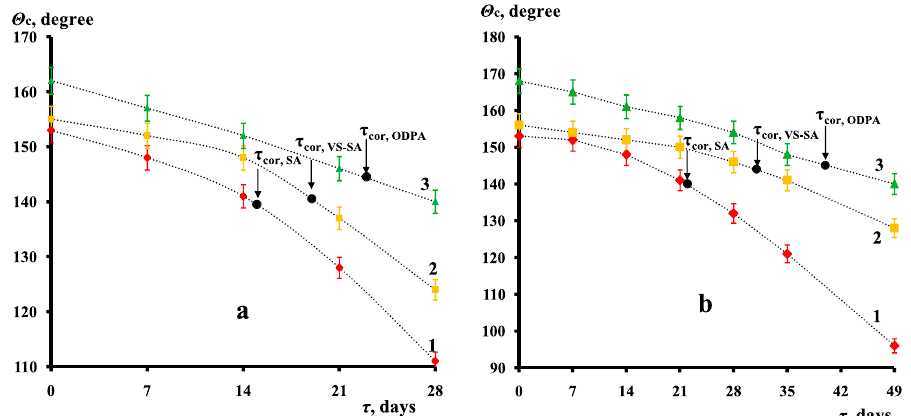
Figure 7. Change in the contact angle θ c on alloy 6063 samples from the time of exposure of the samples in SSC, previously subjected to LP-1 ( a ) and LP-2 ( b ) and then modified in ethanol solutions containing: 1 —10 mM SA; 2 —layer by layer 10 mM vs. and 10 mM SA; 3 —1 mM ODPA. The arrow